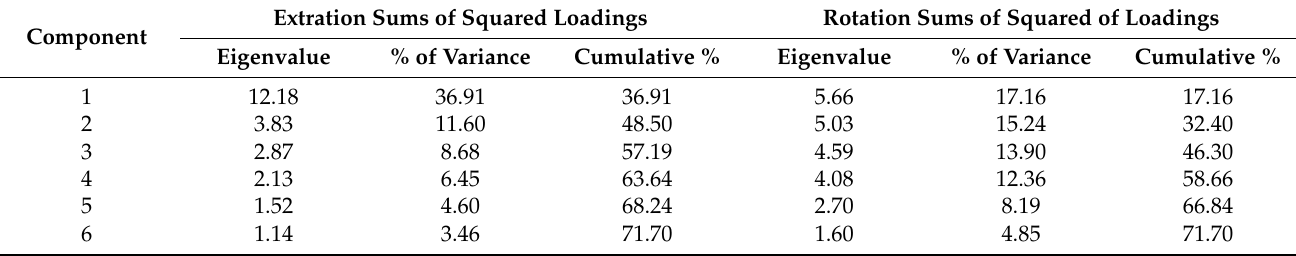
Table 2. Harman one-way test statistics for common method biases.